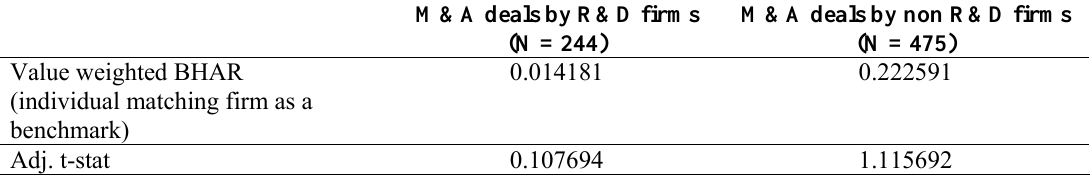
Table 8. Buy-and-hold abnormal returns (BHAR) for acquiring firms (with 36 monthly returns following the deal